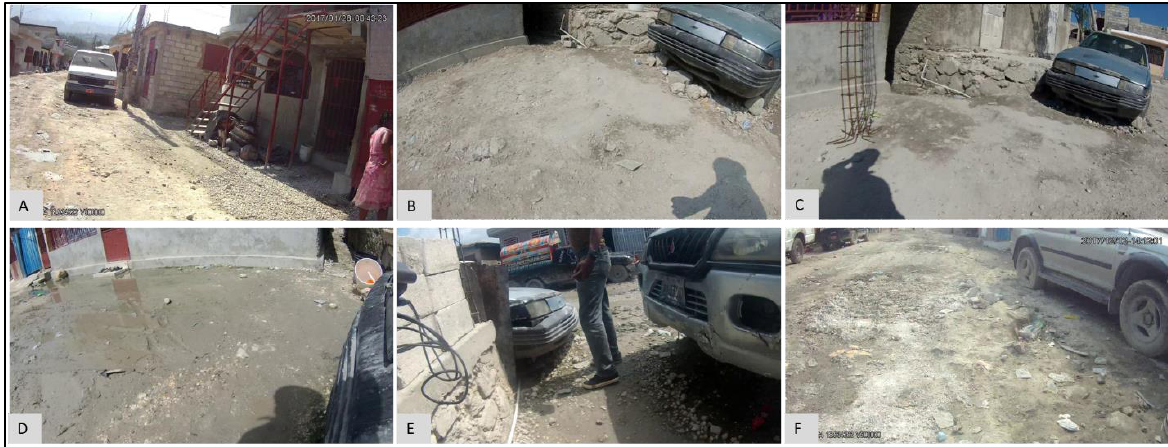
Figure 9. SV image frames for M13 water point for: ( A ) January, ( B ) February, ( C ) March, ( D ) July, ( E ) October, ( F ) December.